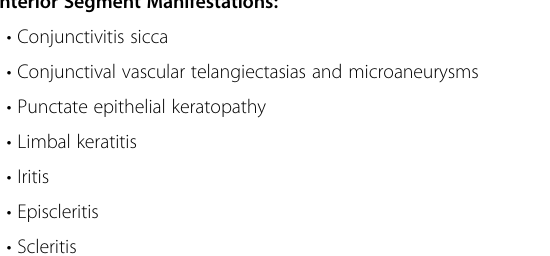
Table 3 Ocular Manifestations of Antiphospholipid Syndrome